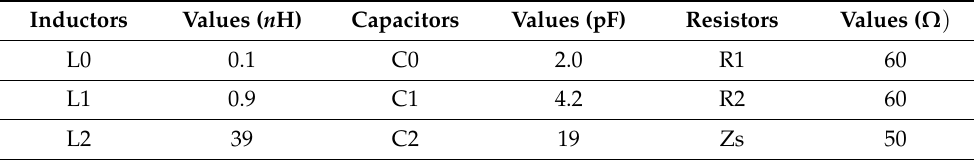
Table 2. Values of the components used in the circuit model.